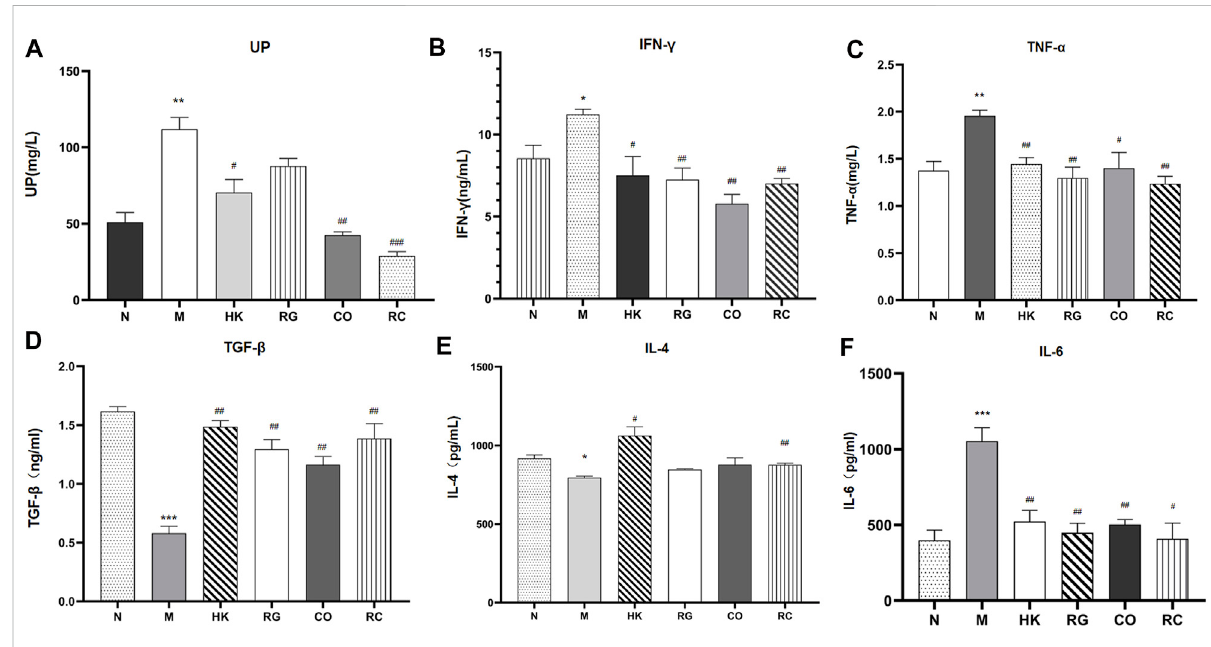
FIGURE 4 Concentrationandexpressionofrelatedbiochemicalcytokines.(Dataaremeans±SEM. (A) UP; (B) IFN- γ ; (C) TNF- α ; (D) TGF- β ; (E) IL-4; (F) IL- 6. *** p < 0.001 vs. normal group; ** p < 0.01 and * p < 0.05 vs . normal group; ## p < 0.01 and # p < 0.05 vs . model group. n =